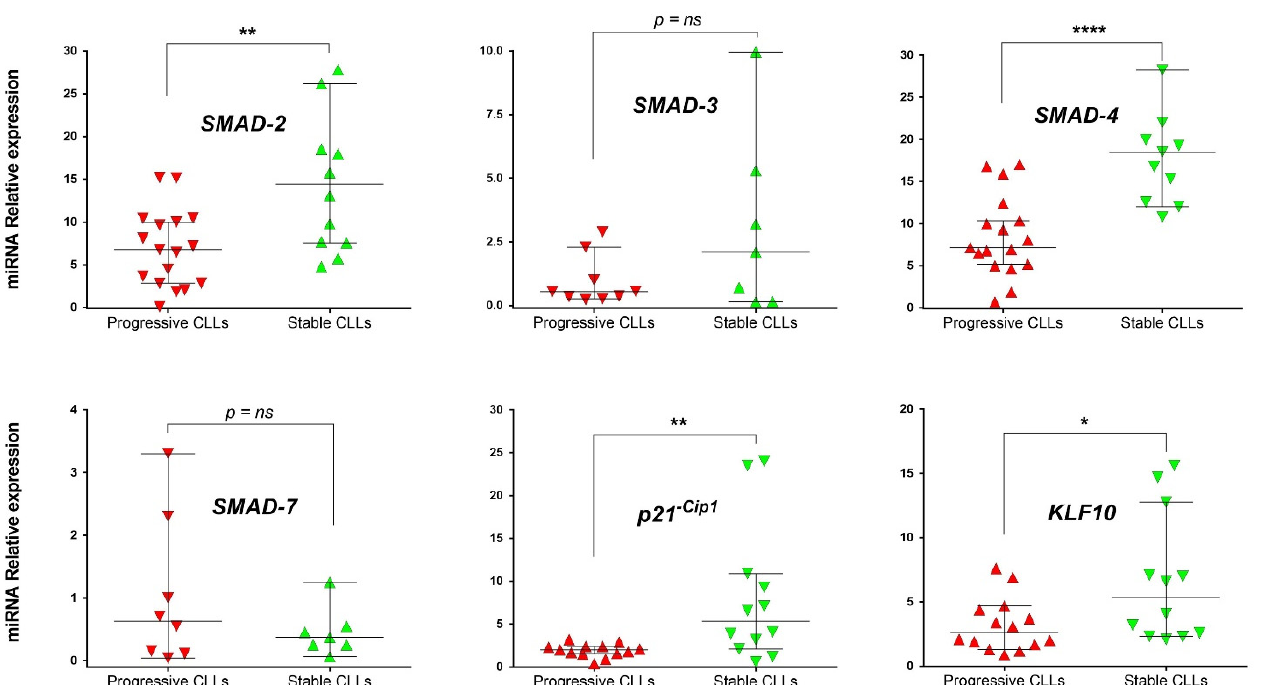
Figure 2. mRNA levels expression of SMAD proteins and of specific target genes modulated by TGF- β pathway activation. Relative expression of SMAD-2, SMAD-3, SMAD-4, SMAD-7, p21 − Cip1 , and KLF10 mRNAs were compared by q-PCR between progressive and stable U-CLL subgroups. Mann– Whitney Unpaired test and median with 95% CI are depicted. GAPDH was used as an endogenous control, and cDNA of MEC-1 cells were used as a reference sample. The relative expression was calculated as 2 −ΔΔ Ct . In all cases, p < 0.05 was considered statistically significant, (* = p < 0.05, ** = p < 0.01, and **** = p < 0.0001, ns = not significant).